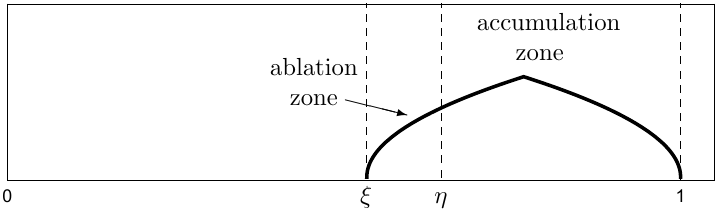
Figure 4. The snow line η separates the ablation zone from the accumulation zone. The variable ξ denotes the ice